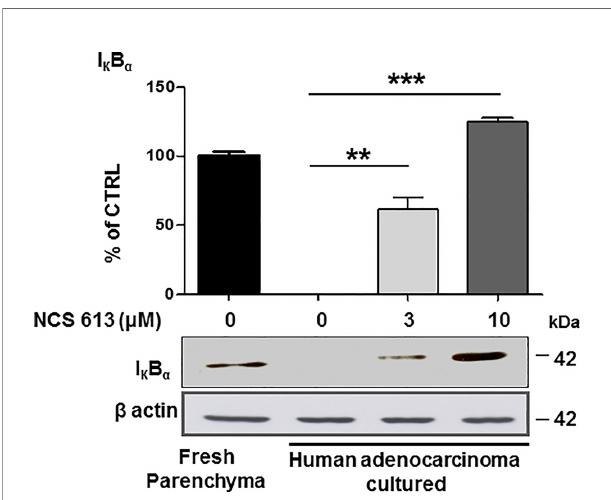
FIGURE 4 | Concentration dependent effect of NCS 613 treatment on I k B a detection in adenocarcinoma explants. I k B a was detected in fresh human lung parenchyma. After a 72 h culture period, I k B a was undetectable in control adenocarcinoma explants suggesting a high in fl ammation level. Three and 10 µM NCS 613 treatment reestablished I k B a detection level (n= 4). Unpaired Student ’ s t -test. Mean ± SEM. ** p < 0.01 and *** p <